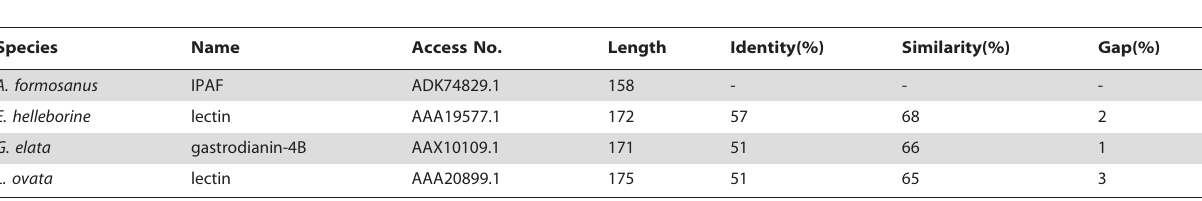
Table 1. Amino acid sequence comparison of IPAF with lectins from Orchidaceae